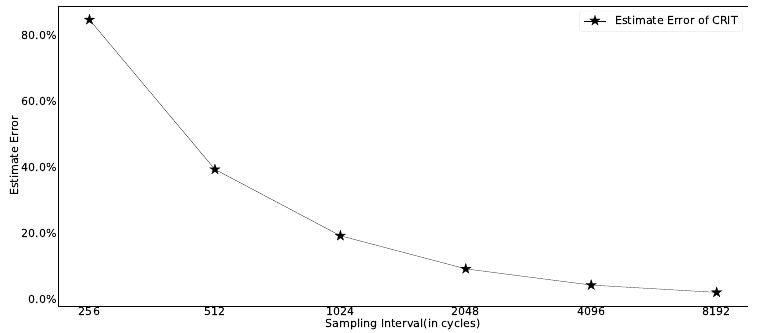
Figure 5. Critical path increase for different sampling periods.